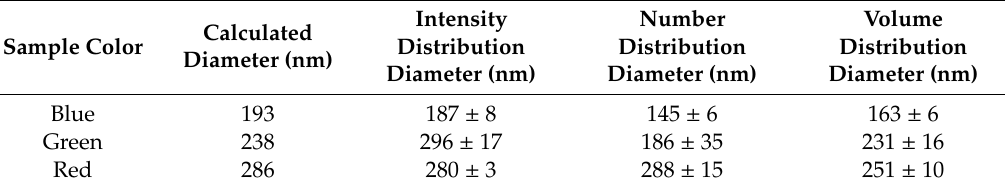
Table 2. The sample color and various diameters of silica nanoparticles of samples.